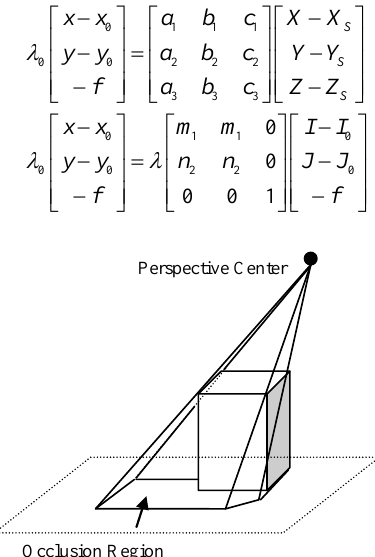
Figure 1. The occlusion region around the building